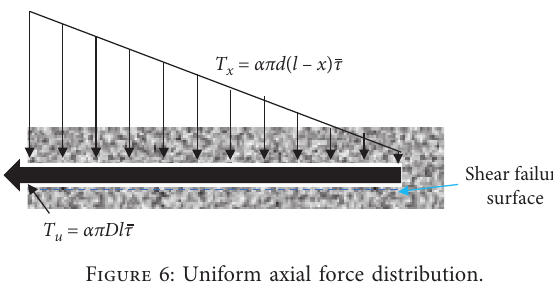
Figure 6: Uniform axial force distribution.